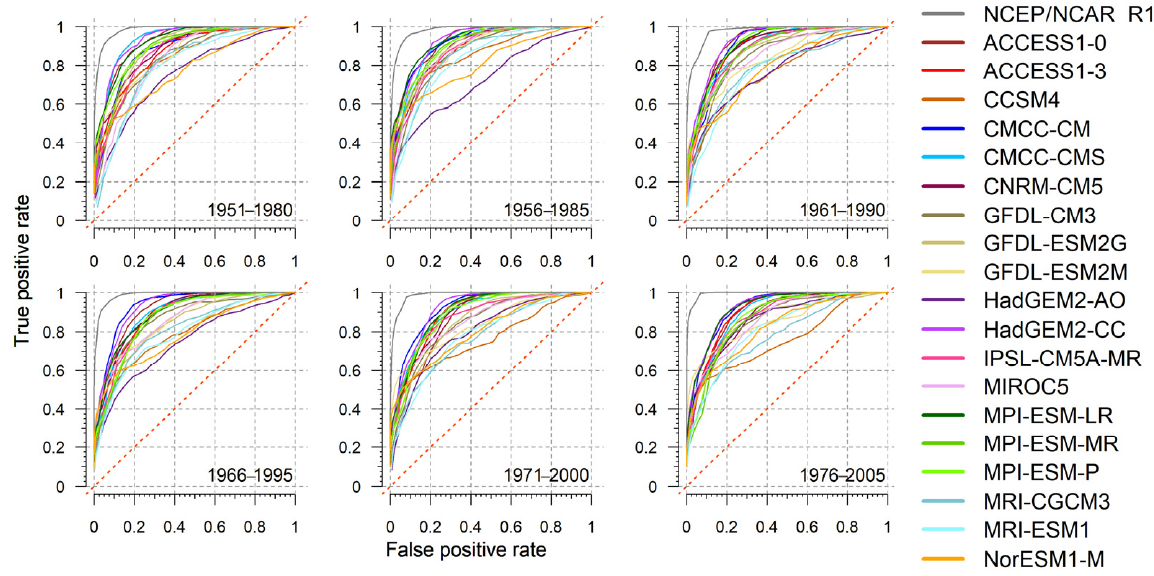
Figure 3. The ROC curves of the NCEP/NCAR R1 and the GCMs over the NH. The CP maps of the ERA-20C (presented in Figure 2) are used as references. Red, dashed lines have a slope of 45°.